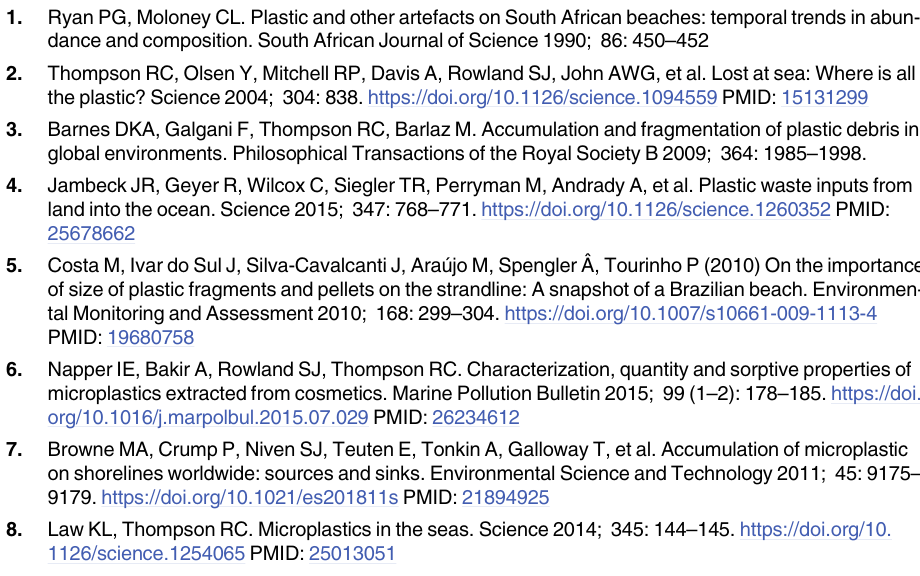
S1 Table. Details of sampling location and quantity (microfibres per 50 ml of sediment, MF50) and type (polymer) of fibres